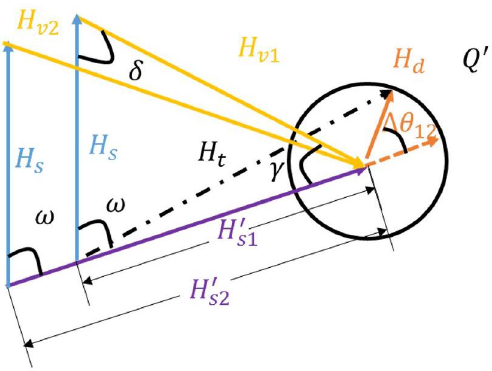
Figure 2. Diagram with virtual